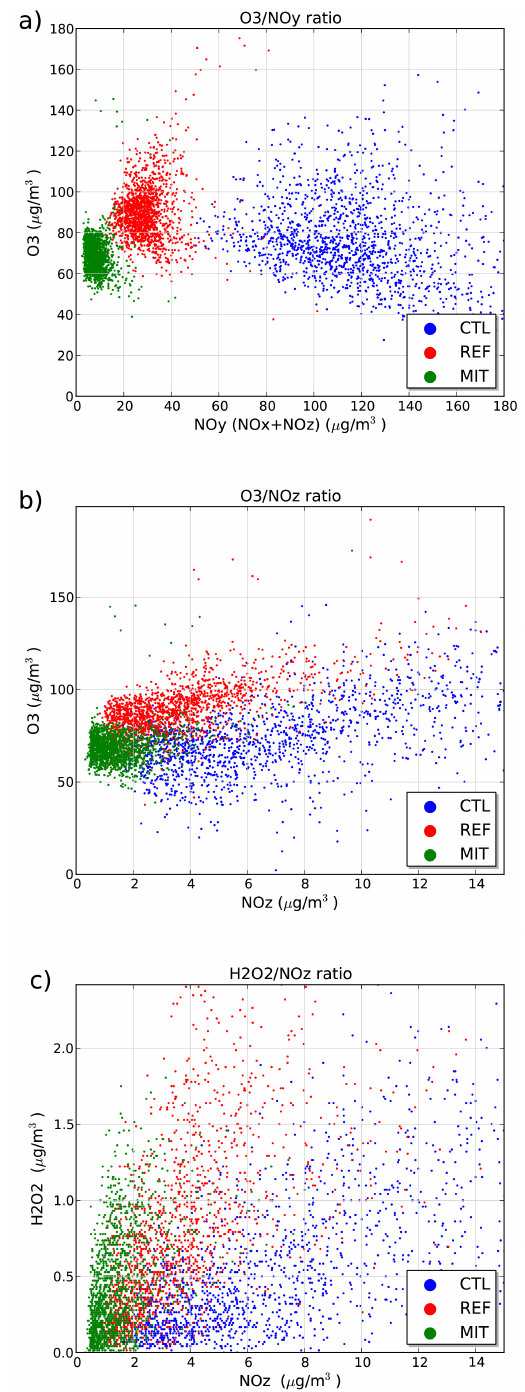
Figure 6. Ozone chemical regime indicators for the control run and the two future projections. Dots represent daily means, averaged during the ozone period over the grid cells of the downtown Paris area.